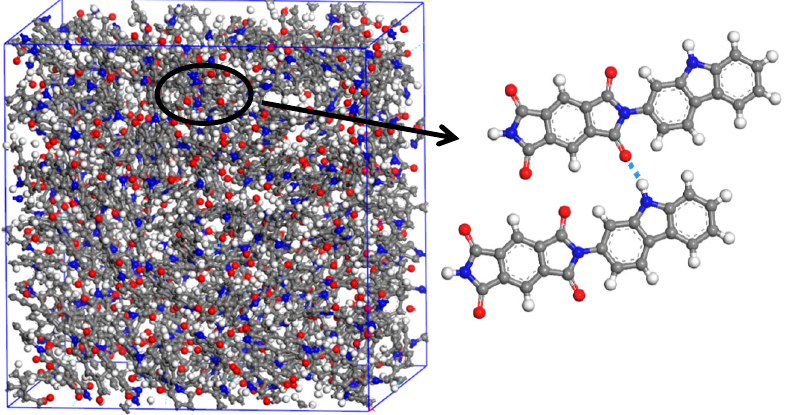
Figure 6. H-bonds between -HN- and O = C- in imide rings in simulation cell of 2,7-CPI. (red: oxygen atoms; blue: nitrogen atoms; white: hydrogen atoms; grey: carbon atoms).